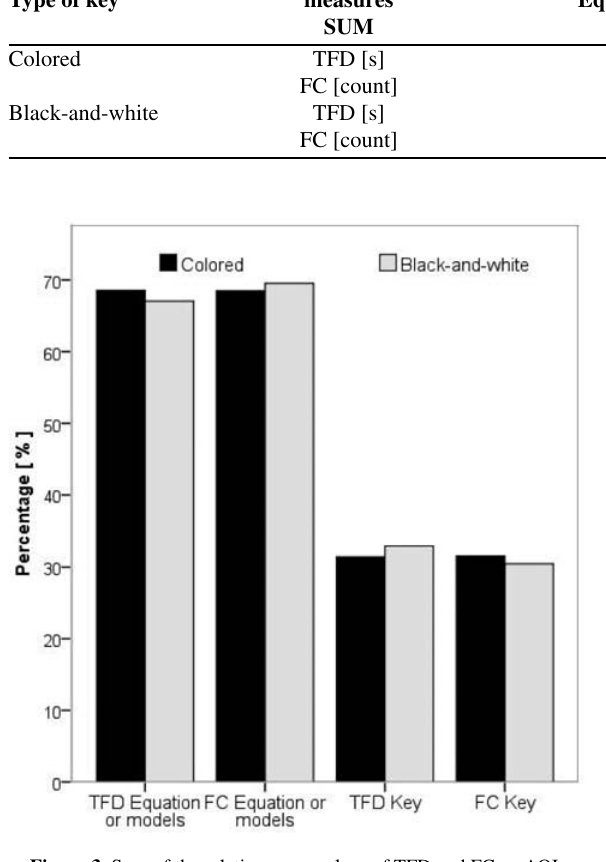
Figure 3. Sum of the relative mean values of TFD and FC on AOI- s of colored versus black-and-white explanatory